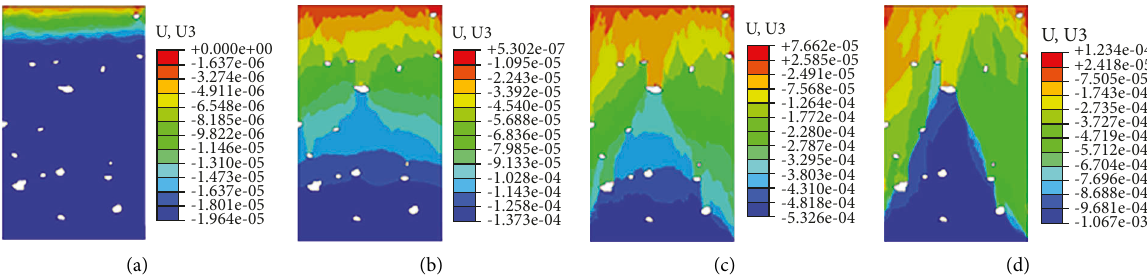
Figure 15: Vertical displacement graphs under different loading displacement. (a) s � 0.02mm. (b) s � 0.137mm. (c) s � 0.533mm. (d) s � 1mm.